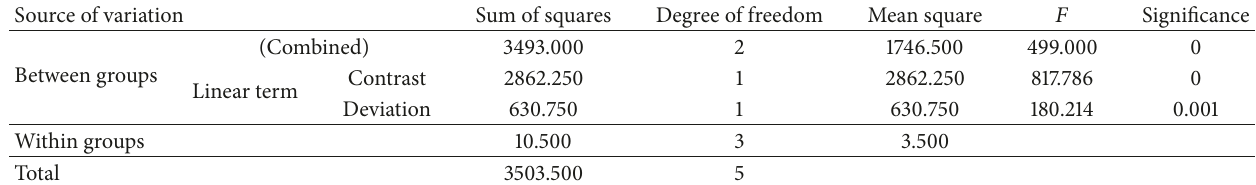
Table 9: ANOVA: single factor between the groups of different storage temperatures on rutting factor. Source of variation Sum of squares Between groups Within groups